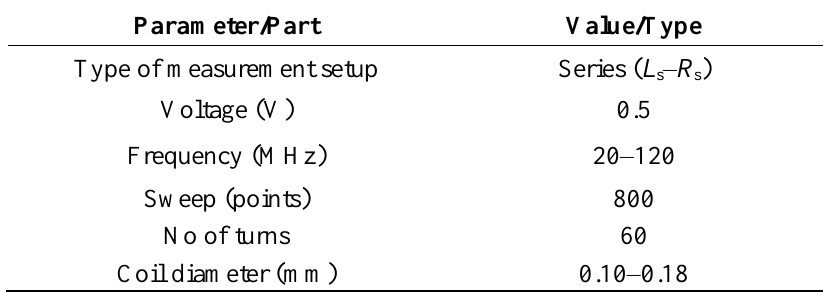
Table 2. Specification for frequency characteristics experimental